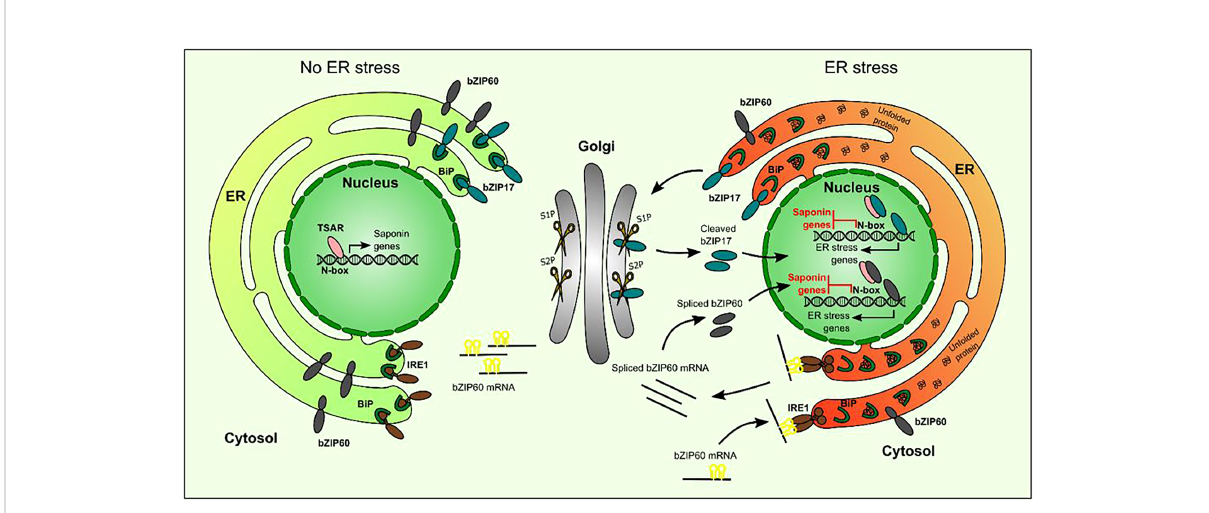
FIGURE 8 Hypothetical model of actionof bZIP17 and bZIP60 and TSAR undernormal and ER stress conditions. Undernon-ER stress conditions, TSAR can bind to the N-boxpresent inthe promoters of TS biosynthesisgenesand activate theirexpression. This can occur both inthe absence and presence ofJAs. Under ERstress conditions, unfolded proteins accumulate and bind to BiP in the ER. This triggers IRE1 to perform unconventional splicing of bZIP60 mRNA as wellasthe release of bZIP17 from the ERand its cleavageby proteases in the Golgi apparatus. The resultingactive forms ofbZIP17 and bZIP60 translocate to the nucleus, wherethey can transactivate the expression ofERstress-responsive genes but also hinder the TSARs and thereby repress the transactivationof TS biosynthesis gene expression. TSAR, triterpene saponin biosynthesis activating regulator; bZIP, basic leucine zipperTF; BiP,binding protein chaperone; IRE1, inositol-requiring enzyme 1; S1P, site-1 protease; S2P, site-2